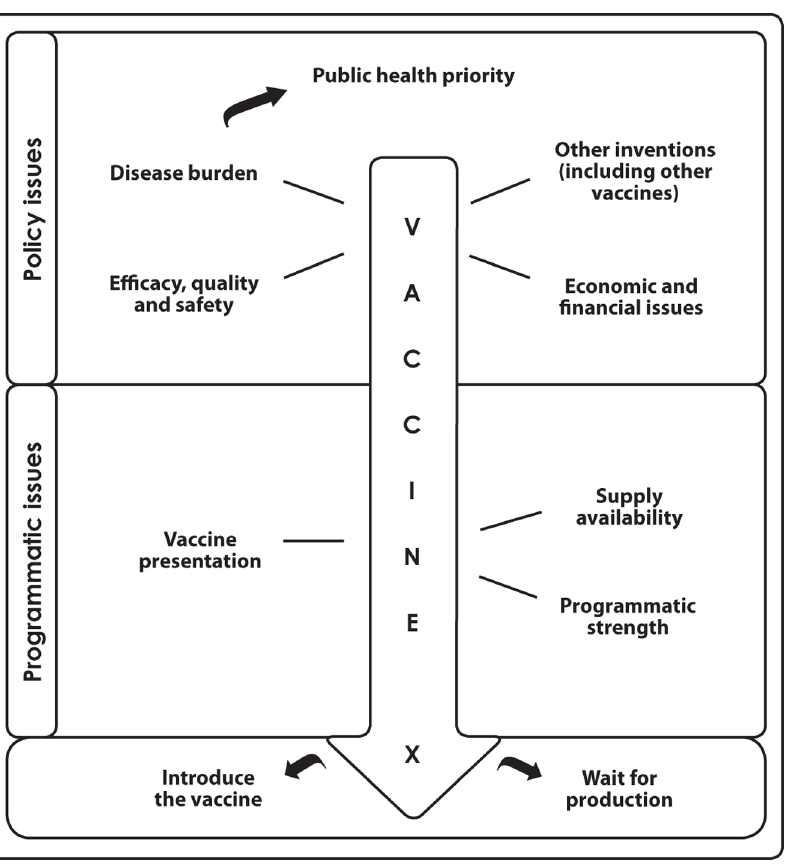
Figure 1. Flowchart of key issues to be considered before vaccine introduction [Source: WHO, 3].